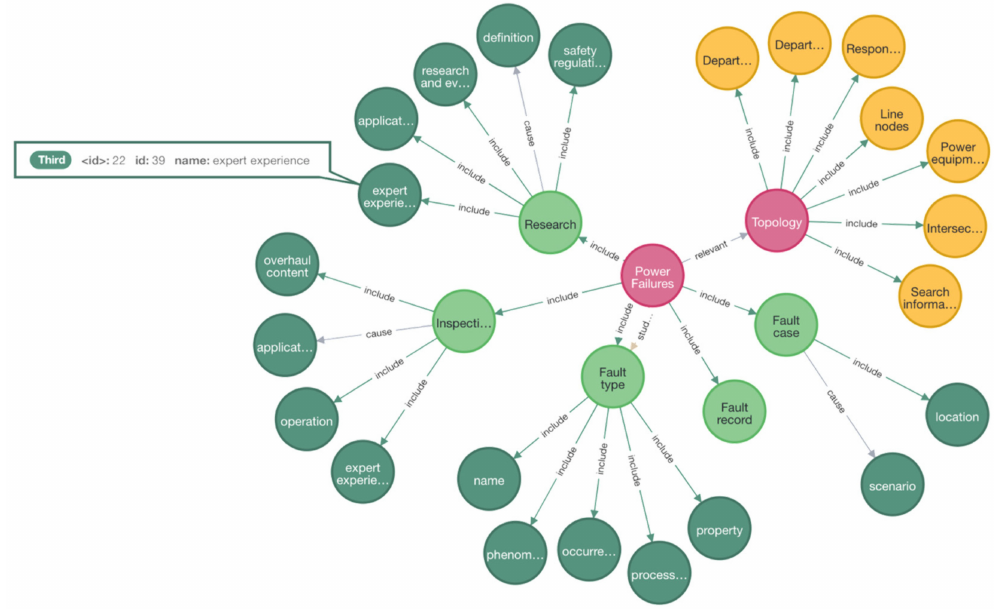
Figure 3. Multi-business power knowledge graph ontology layer